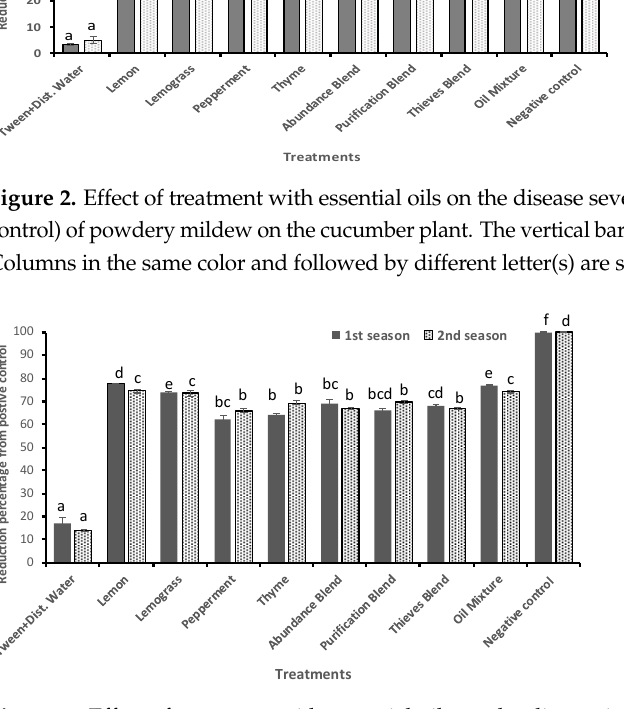
Figure 3. Effect of treatment with essential oils on the disease incidence (reduction % from positive control) of powdery mildew on the cucumber plant. The vertical bar represents the standard error ( n = 3). Columns in the same color and followed by different letter(s) are not significantly different at p < 0.05.